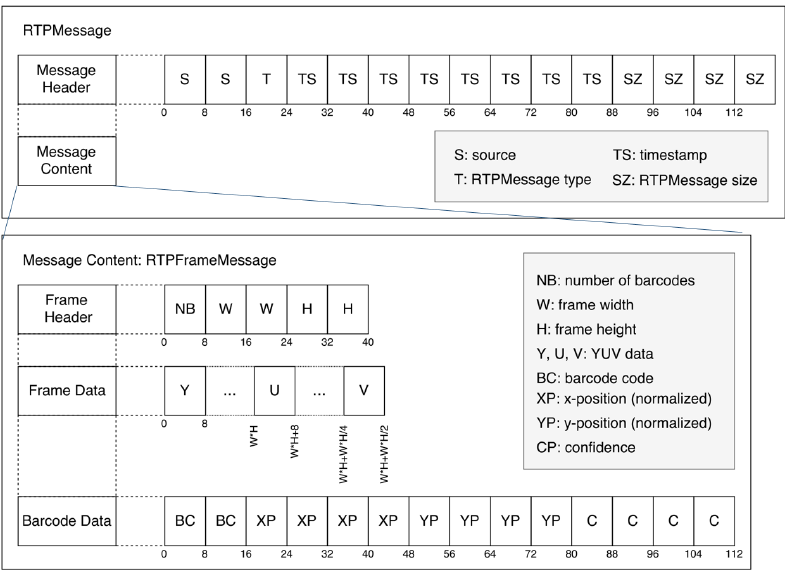
Figure 10. RTP message structure composed of a message header and content.